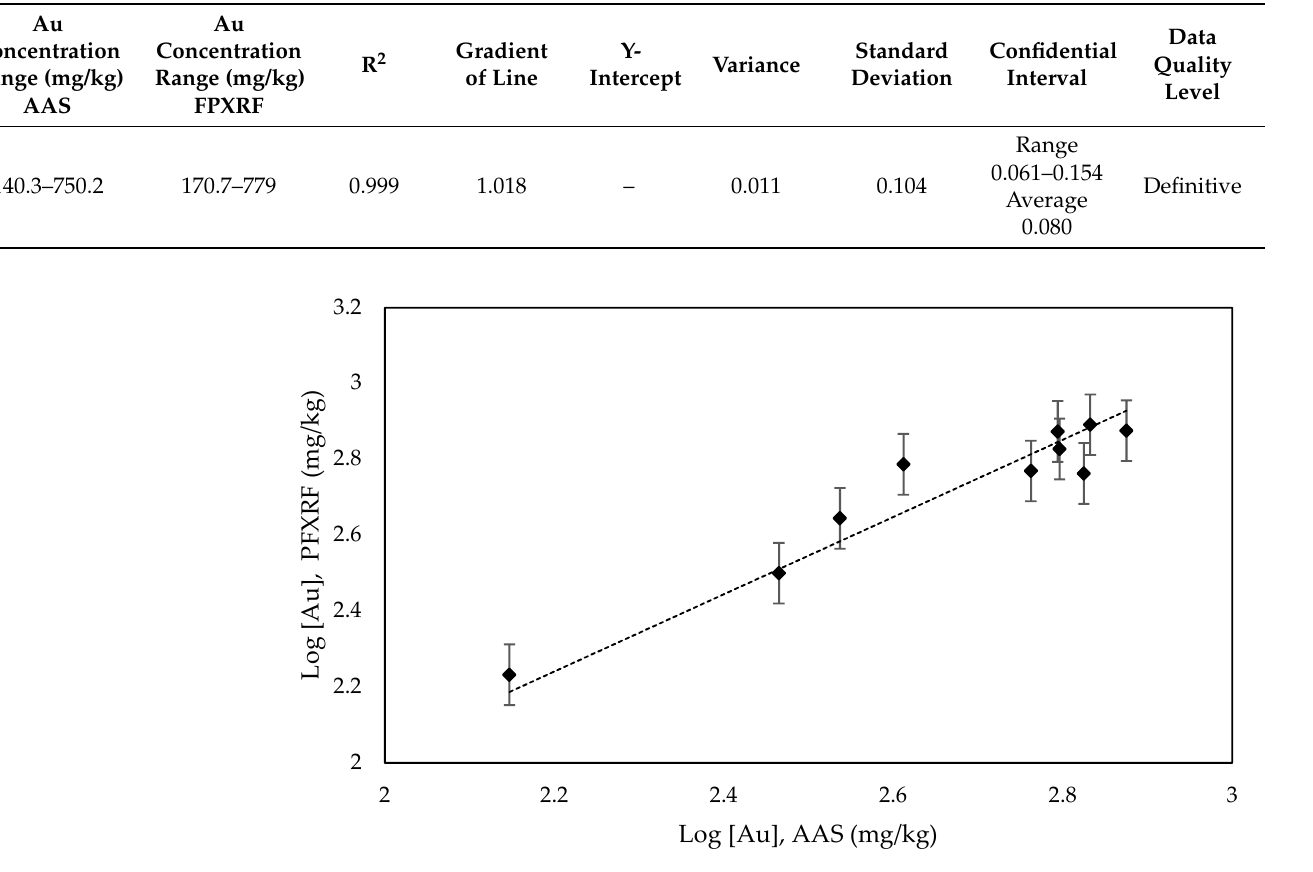
Figure 7. Statistical confidence determined for the model (4).